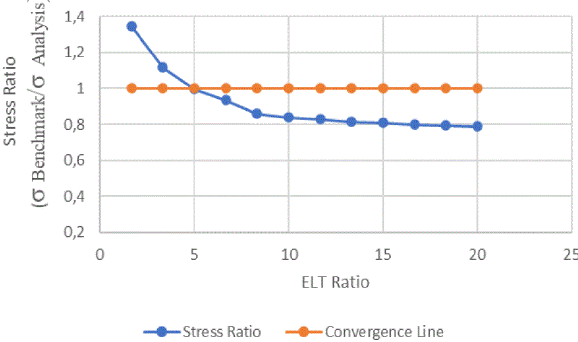
Figure 3: Mesh convergence study: observation to the stress behav- ior